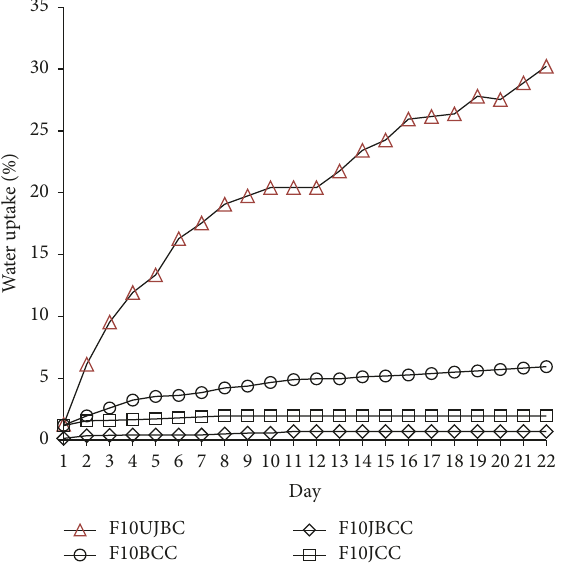
Figure 9: Water absorption percentage of UJBC, BCC, JBCC, and JCC for 22 days for 10wt% fiber